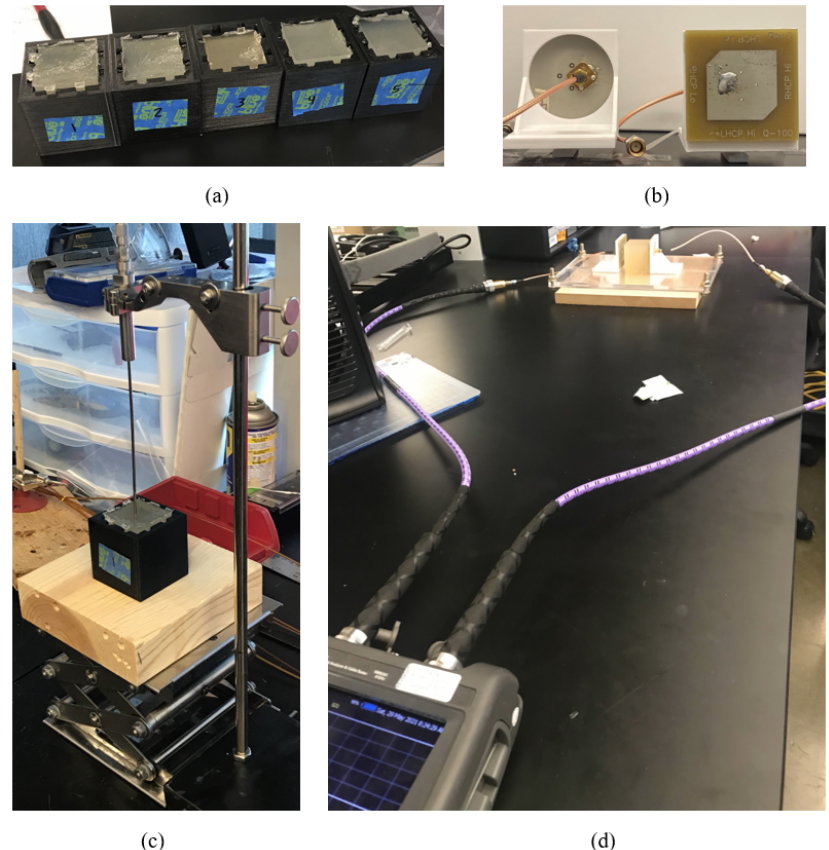
Figure 1. Setup for the gel studies: ( a ) five agar gels with varying water content, ( b ) close-up image of the antennas, ( c ) measurement of dielectric properties, and ( d ) capturing of electromag- netic measurements.